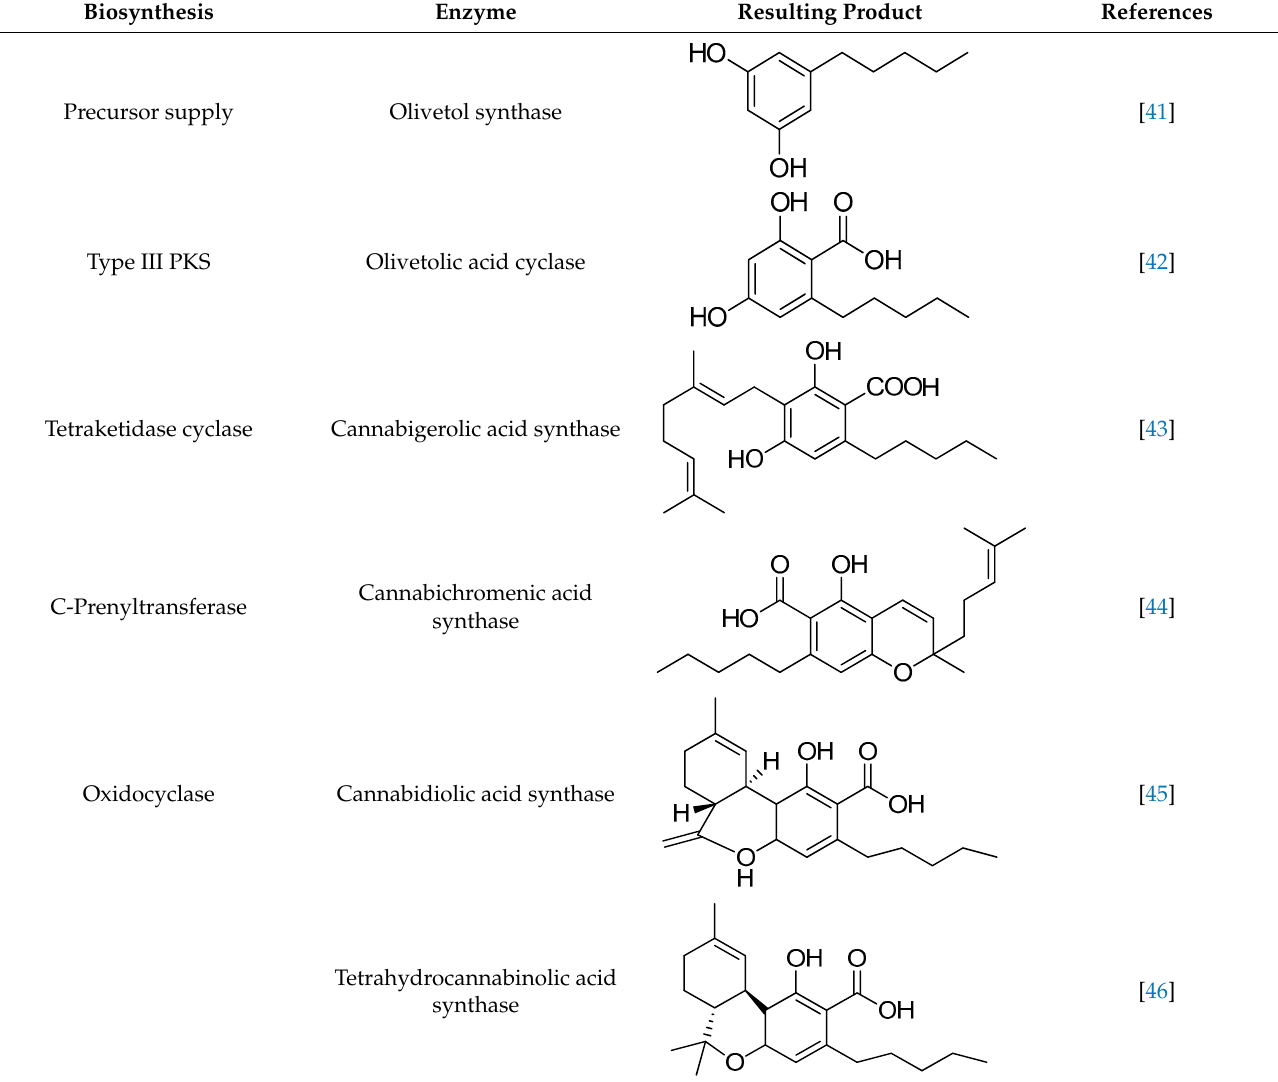
Table 1. The Enzymatic Reaction in the biosynthesis of phytocannabinoids.